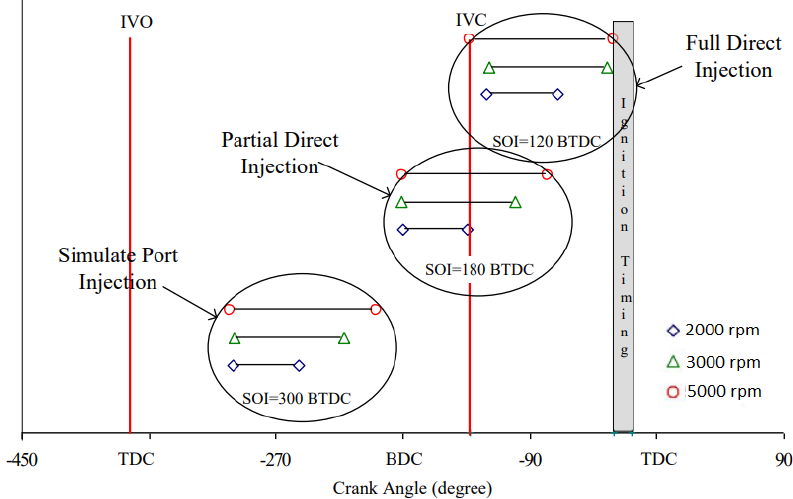
Figure 14. Injection duration for different injection timings for engine speeds 2000 rpm, 3000 rpm, and 5000 rpm [162].